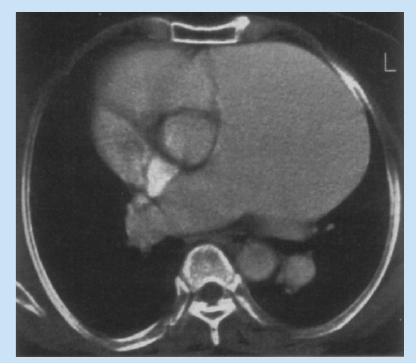
Fig. 2. Axial CTscan of the chest at the level of the main pulmonary